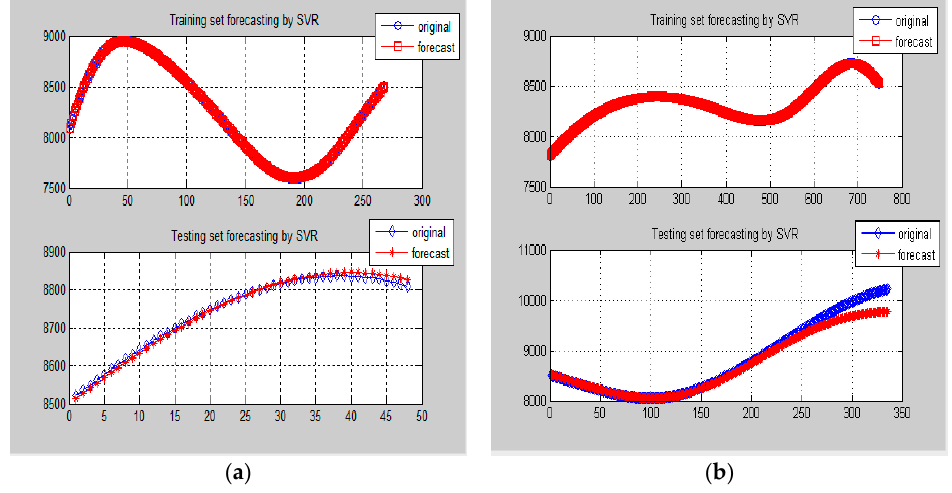
Figure 8. Comparison of forecasting results by SVR-GA model for Data-II (Example 1). ( a ) One-day ahead forecasting on 8 May 2007; ( b ) One-week ahead forecasting from 18 to 24 May 2007. Table 4. The SVR-GA’s parameters for Data-II (Example 1).